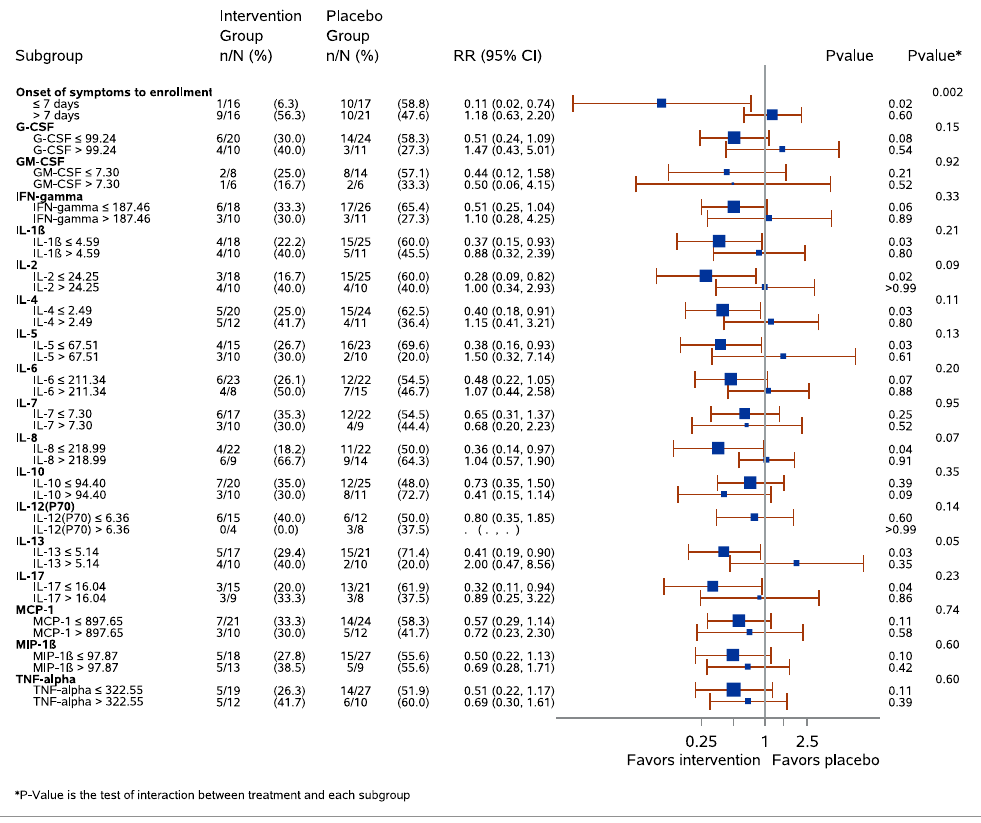
Figure 3. Forest plot demonstrating the association of interferon-β1b and lopinavir–ritonavir treatment on 90-day mortality in patients with Middle East respiratory syndrome categorized into two subgroups of early and late treatment and according to higher and lower levels of each of the cytokines using the upper tertile (67%) as a cutoff point. The results are displayed as relative risks and 95% confidence intervals (CI), and p-values. Additionally, p-values for the interactions are reported. Plasma cytokine concentrations are expressed in pg/ml. There was heterogeneity of treatment effect on 90-day-mortality according to the level of IL-2, IL-8 and IL-13 as demonstrated by testing for interaction (p-value for interaction = 0.09, 0.07, and 0.05, respectively) while the interaction was were not significant for other cytokines (p > 0.1). G-CSF: granulocyte-colony stimulating factor; GM-CSF: granulocyte–macrophage colony-stimulating factor; IFN: interferon; IL: interleukin; MCP: Monocyte chemo-attractant protein; MIP: Macrophage inflammatory protein; TNF: tumor necrosis